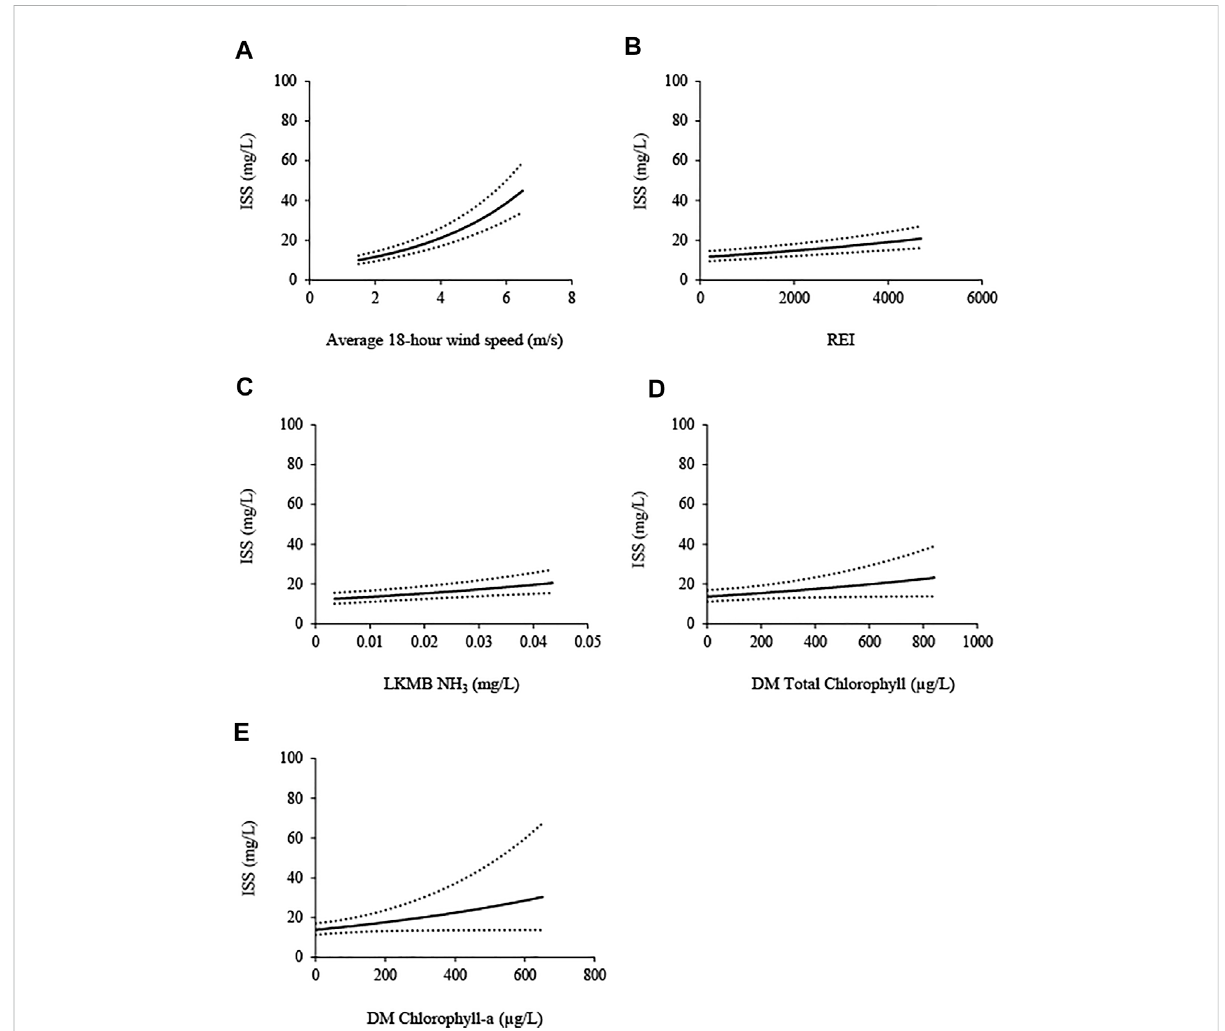
FIGURE 2 Inorganic suspended solids (ISS; mg/L) intheDeltaMarsh(DM) carpexclusion zone(west, east1,and east 2units), 2009, 2010,and 2012 – 2018, modeledinrelationto: (A) averagewindspeedoverthepreceding18 hours(average18-hwindspeed;m/s), (B) relativeexposureindex(REI), (C) Lake Manitoba (LKMB) ammonia (NH 3 ; mg/L), (D) DM total chlorophyll ( μ g/L), and (E) DM chlorophyll-a ( μ g/L). 95% con fi dence intervals (±; dotted lines) are shown. Each covariate effect was isolated bysetting all other covariates to their mean values, averagingover unit*period effects and setting random effects of site, year, and site*year to